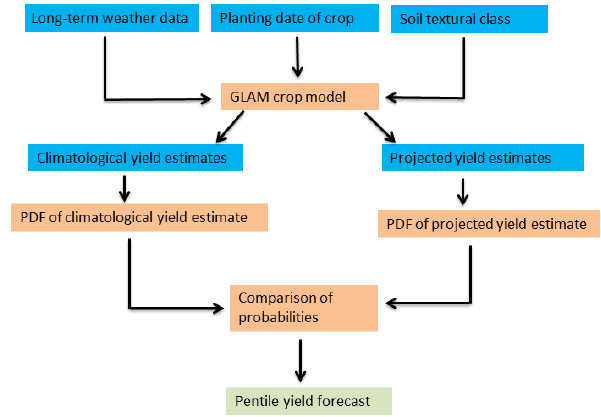
Figure 7. Process flowchart for crop yield forecasting within the TAMSAT-ALERT system. The blue boxes represent input data sources, the orange represents the processes involved in the system and the green box shows the final probabilistic forecast for the crop yield.